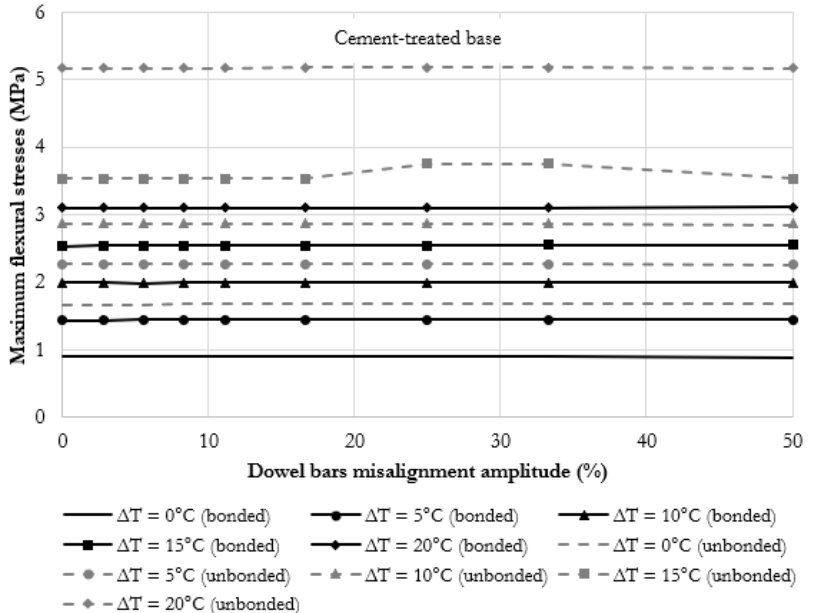
Figure 10. Flexural stresses in concrete slabs placed over cement-treated base according to dowel bars uniform horizontal skew and thermal differential.